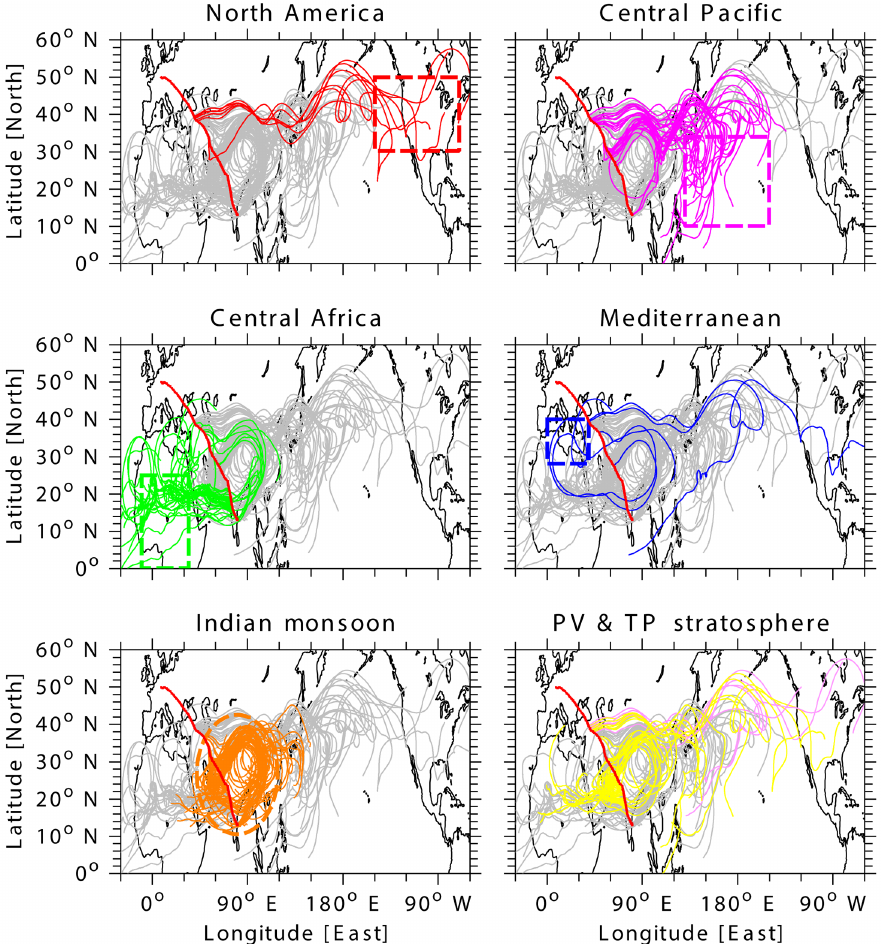
Figure 12. Receptor regions as determined for CARIBIC flight 244 to Chennai on 13 August 2008 (flight track shown with thick red solid line). The panels show all FLEXPART forward trajectories for this flight south of the northern cut-off (40 ◦ N) in grey. For each receptor region, the corresponding trajectories are shown in colour. The dashed lines indicate the boundaries of the receptor regions (boxes and ellipse). Trajectories with stratospheric parts are shown in the lower right panel in yellow for the thermal and pink for the dynamical tropopause